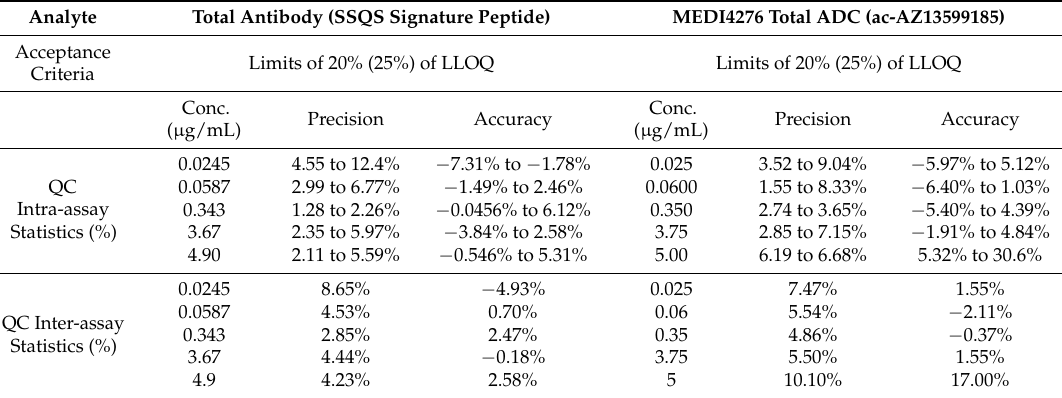
Table 4. Total antibody (MEDI4276) and total ADC (MEDI4276) precision and accuracy.